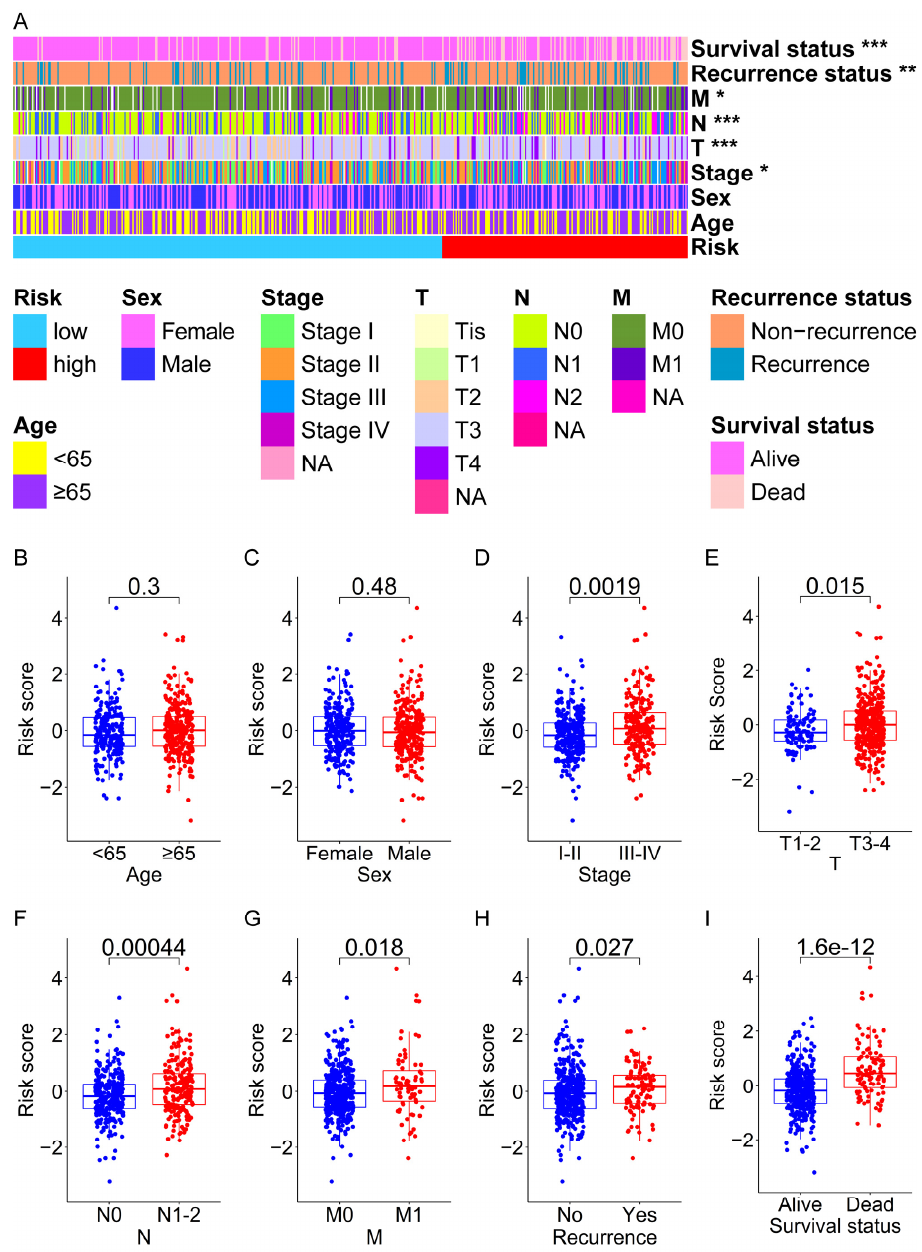
Figure 4. The relationship between the risk score and clinical characteristics of CRC patients in the entire set. ( A ) The heatmap shows the distribution of clinical characteristics of patients between high-risk and low-risk groups. The box plots show that there is no significant difference in risk scores between patients with different ages ( ≥ 65 years old, <65 years old) ( B ) or patients with different sexes (female, male). ( C , D ) The box plot shows the risk scores of CRC patients with stage III–IV are significantly higher than that of stage I–II. ( E ) The box plot shows that the risk scores of CRC patients with the T3–4 stage are significantly higher than those of T1–2. ( F ) The box plot shows that the risk scores of CRC patients with the N1–2 stage are significantly higher than those of N0. ( G ) The box plot shows that the risk scores of CRC patients with the M1 stage are significantly higher than those of M0. ( H ) The box plot shows that the risk scores of CRC patients with tumor recurrence are significantly higher than those of tumor non-recurrence. ( I ) The box plot shows that the risk scores of dead patients are significantly higher than those of alive patients. * p < 0.05; ** p < 0.01; *** p <